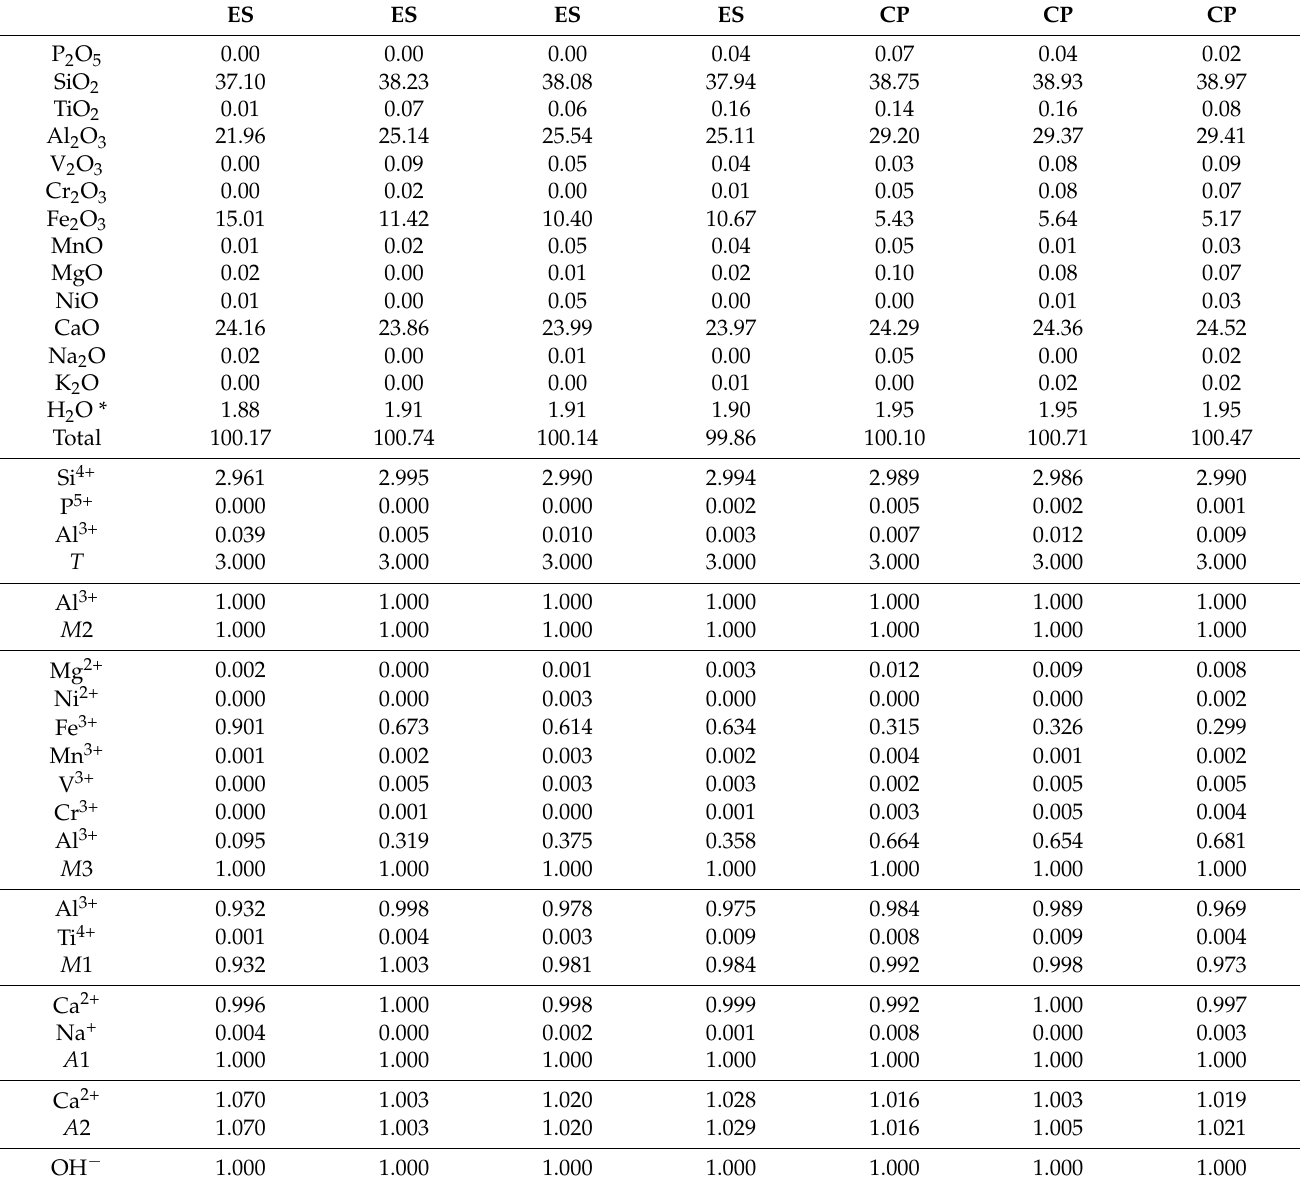
Table 2. Electron microprobe analyses (in wt.% of oxides and apfu of cations) of epidote (ES) and clinozoisite